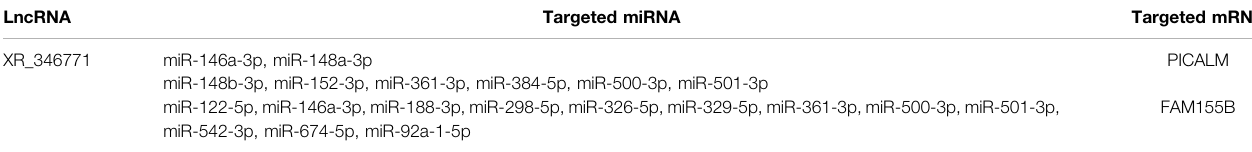
TABLE 7 | LncRNA XR_346771targeted miRNAs and mRNAs.